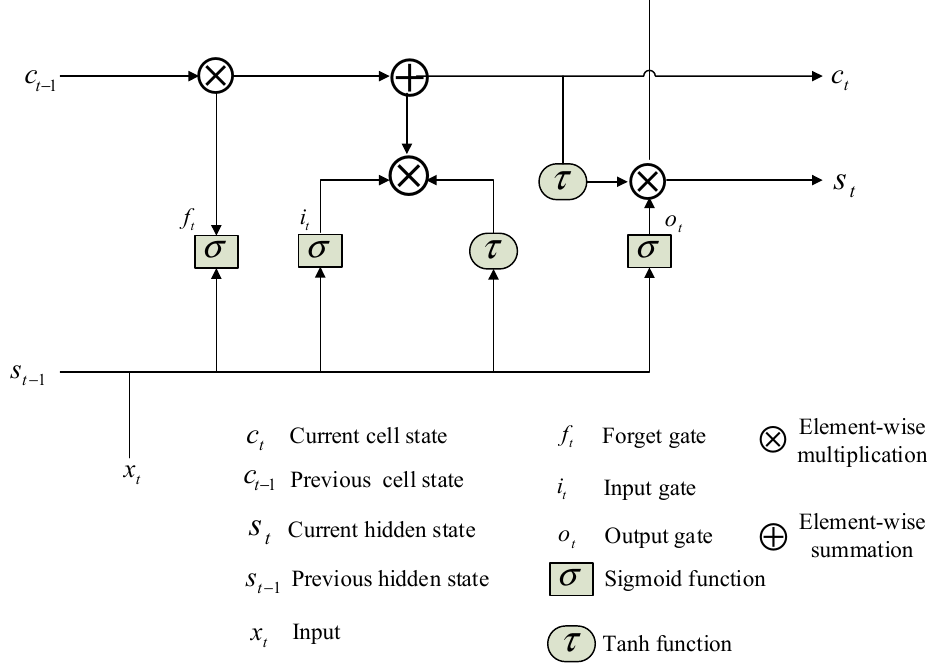
Table 1. Description of selected studies.